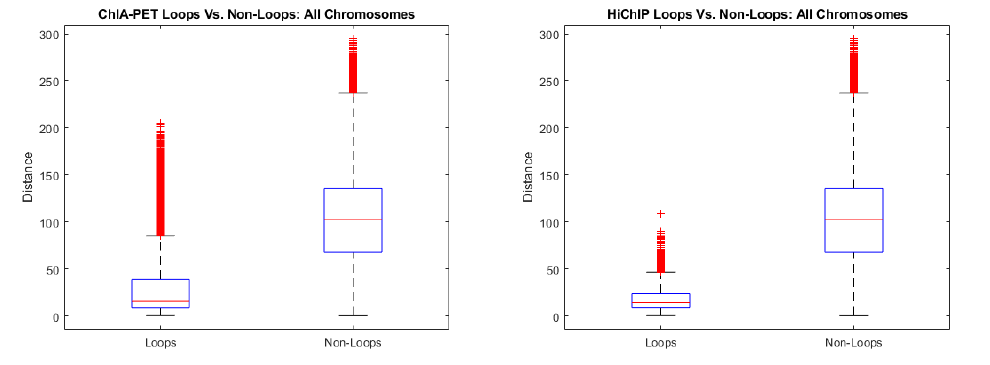
Figure 17. ( a ) Box plots comparing distances within looped regions to distances within non-looped regions for all chromosomes combined identified by the ChIA-PET data. ( b ) Box plots comparing dis- tances within looped regions to distances within non-looped regions for all chromosomes combined identified by the HiChIP